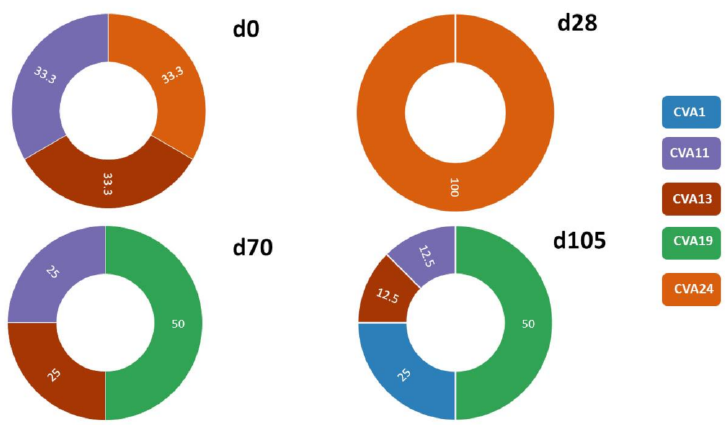
Figure 2. Relative abundance of enterovirus variants recovered and unambiguously identified on the four (0, 28, 70 and 105) sampling days using the SSW. Numbers in chart are percentages reflecting the number of sites where the different EV types were detected relative to the number of sites where EVs were detected and unambiguously typed on any specific sampling day. Please note that d0, d28, d70 and d105 mean EV types detected in samples collected on days 0, 28, 70 and 105, respectively. Additionally, note that 100% in d28 refers to the single CVA24 detected on that day (please see Tables 2 and